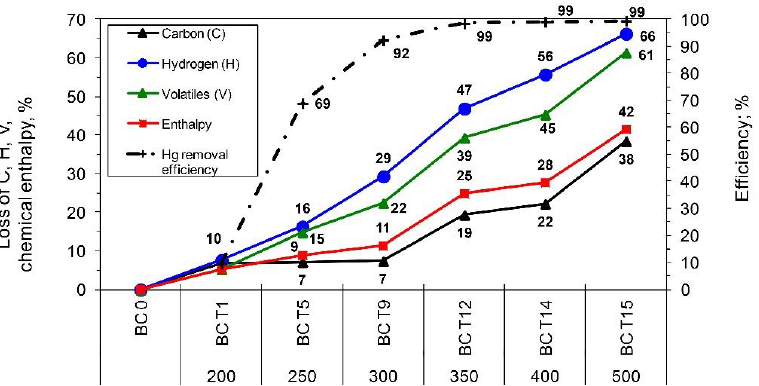
Figure 4. The average change of parameters and composition of refined fuel for lignite; percentage loss of C, H, and V, content, fuel chem. enthalpy vs. process temperature.